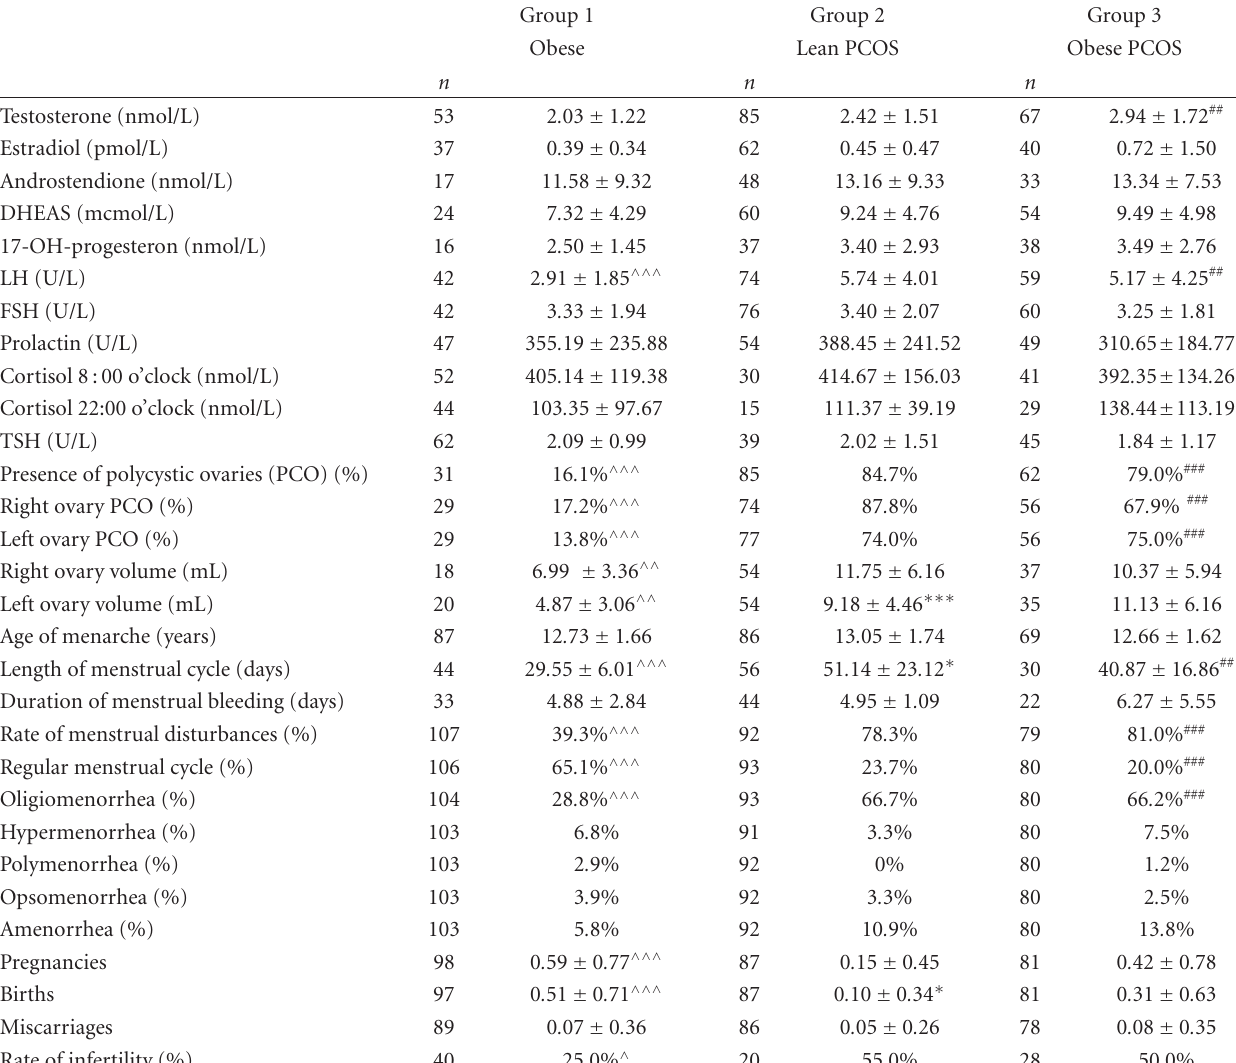
Table 4: Comparison of hormone levels and the indices of ovarian function between the three